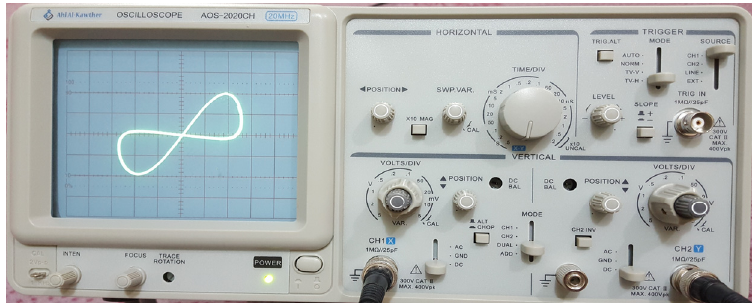
Figure 14. The obtained experimental results of the v M − i M characteristics of the fractional-order memristor.